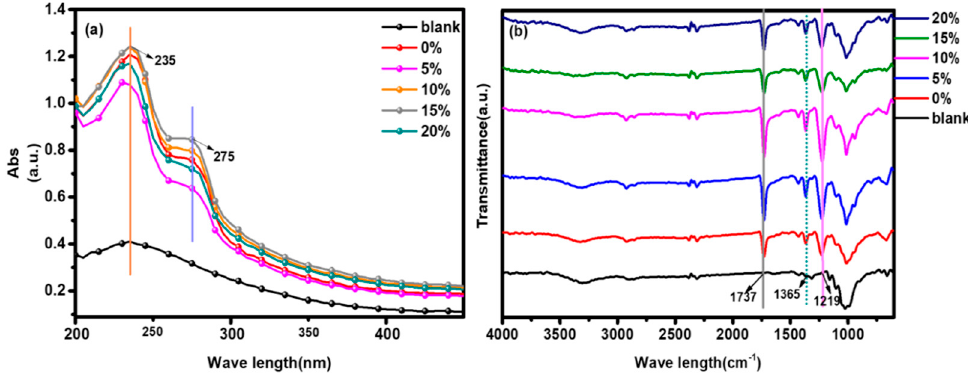
Figure 5. Ultraviolet (UV) and FTIR of the blank paper and paper coated with PVAc and its lignin copolymers containing different fractions of lignin, ( a ): UV absorption ( b ): FTIR absorption.